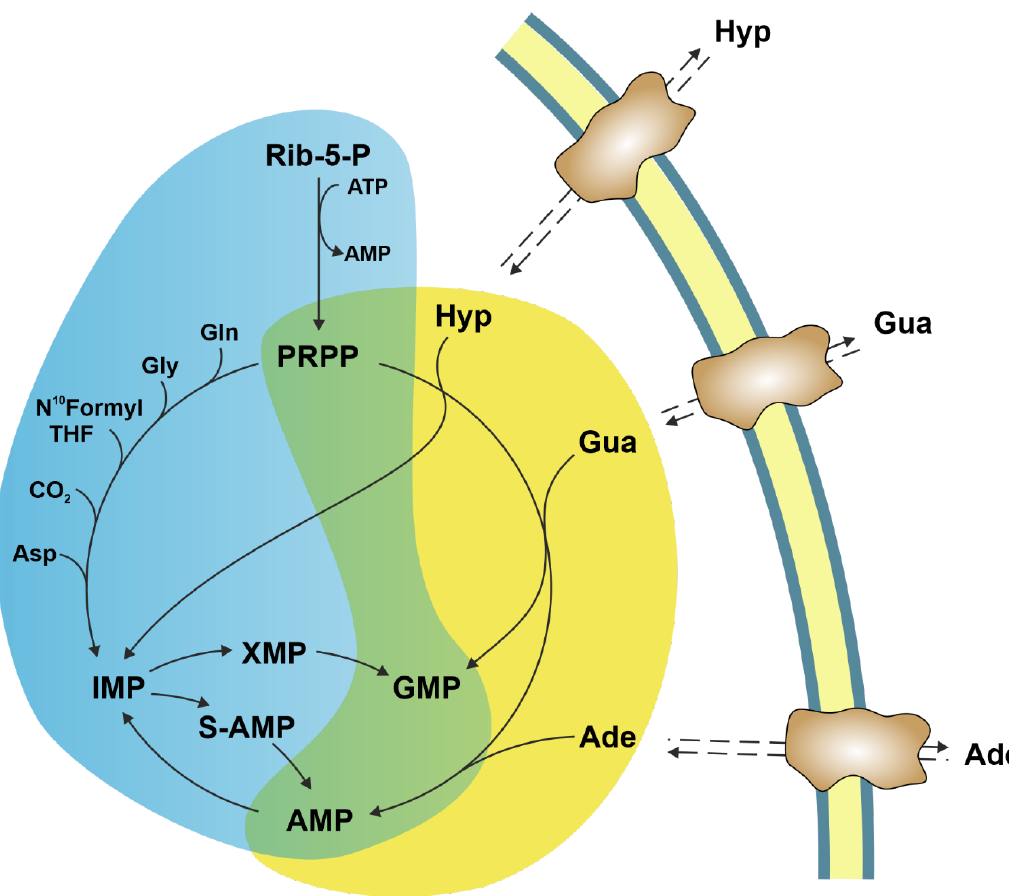
Figure 1 . De novo and salvage pathways for purine nucleotide biosynthesis. Cyan background: de Figure 1. De novo and salvage pathways for purine nucleotide biosynthesis. Cyan